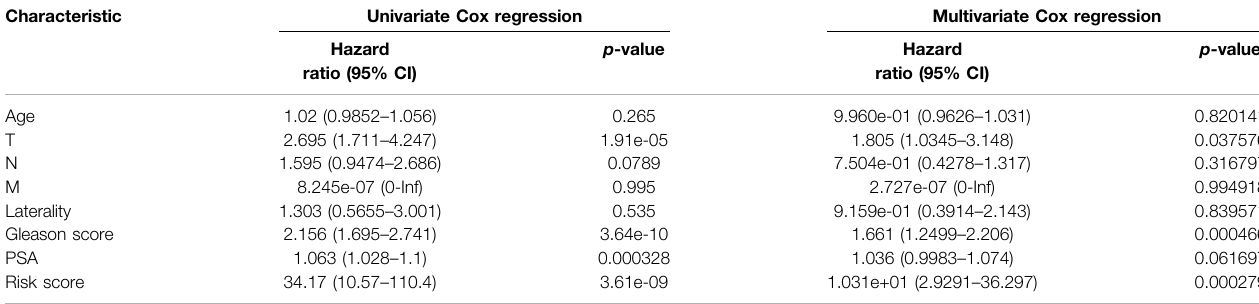
TABLE 1 | Results of univariate and multivariate Cox regression analyses.